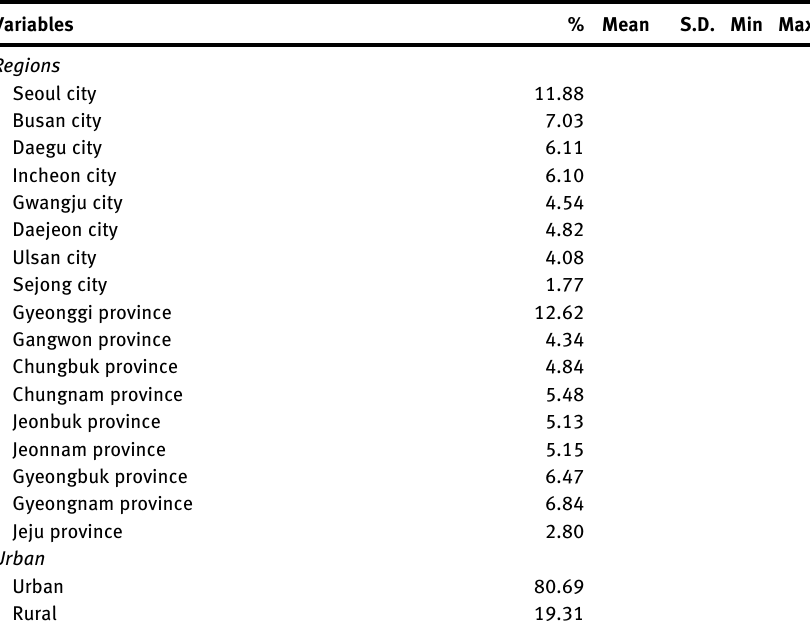
Table  : (continued) Variables % Mean